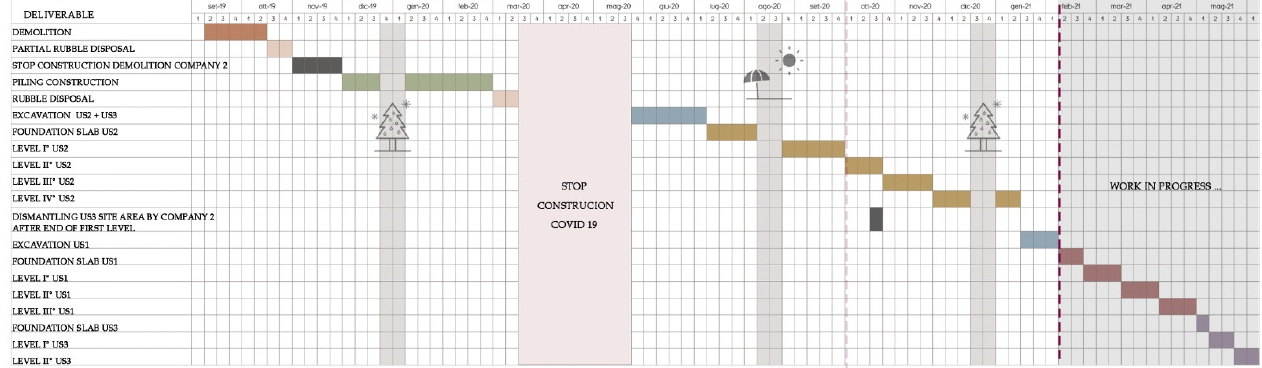
Figure 12. Deliverable scheduling—Case study.